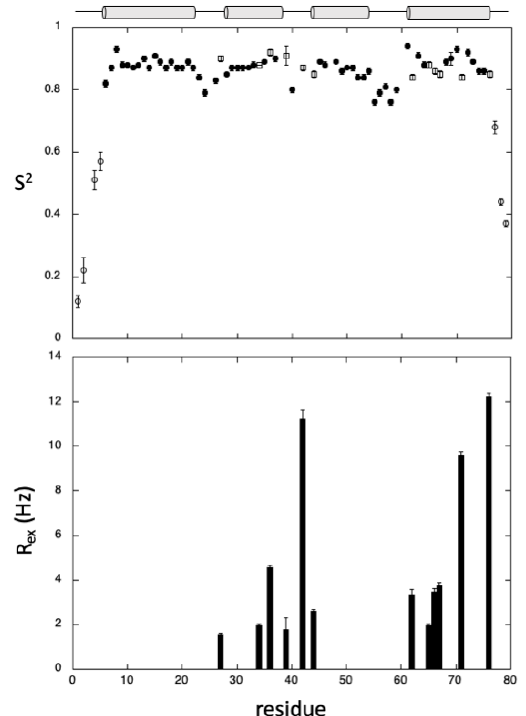
Figure 3. Intrinsic dynamics of GIPC1-GH2. ( Top ) Generalized order parameters S 2 obtained from Lipari–Szabo analysis plotted versus the protein sequence. The regular two-parameter spectral density function (Section 4, Equation (1)) has been used for residues plotted as filled circles, whereas the extended Lipari–Szabo formalism (Section 4, Equation (3)) has been used for residues plotted as open circles. Open squares correspond to residues for which J (0) values have been corrected from exchange contributions (Section 4, Equation (2)). ( Bottom ) R ex contributions obtained from this last equation are reported versus the sequence for residues exhibiting conformational exchange. The location of the four helices in the protein sequence is schematized with cylinders on top of the figure.